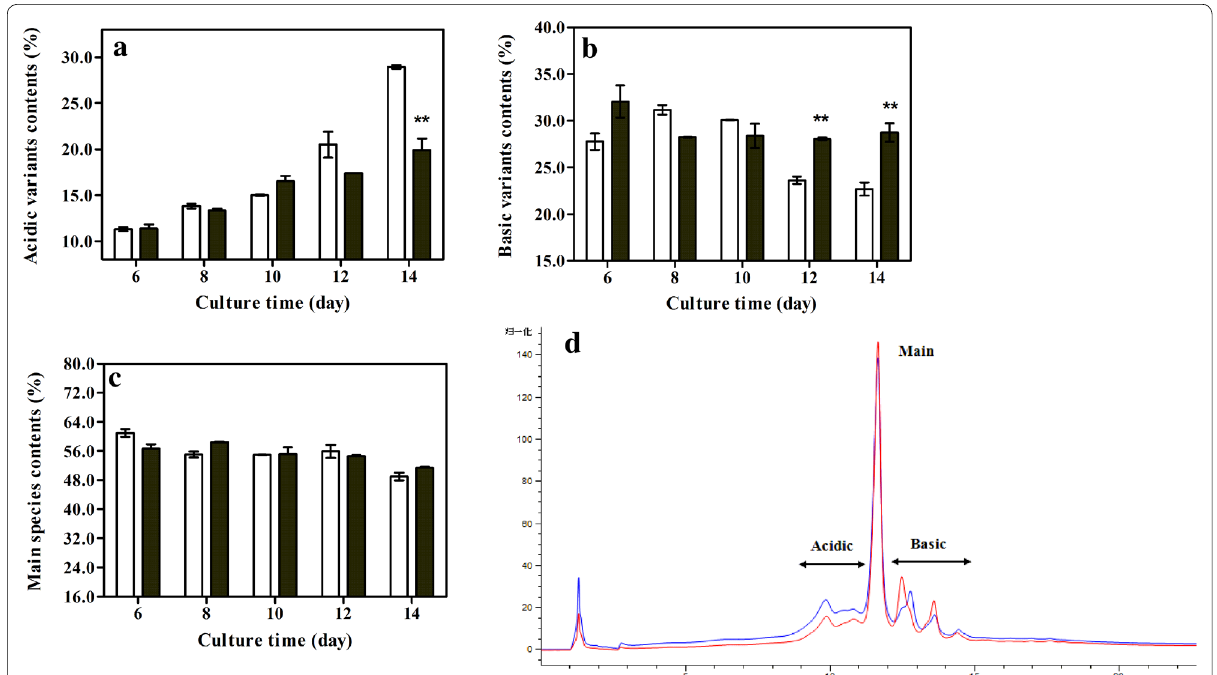
Fig. 2 Profiles of mAb charge variation distribution with different feed medium. a Acidic variant level; b basic variant level; c main variant level. (White bar) control condition; (shaded bar) uridine added condition; d CEX graph of antibodies in different fed‑batch cultures. Red line represents mabs in control culture at day 14; blue line represents mab in uridine added culture at day 14. The error bars indicate the standard deviations from three independent experiments and p ‑values were estimated by two‑tailed Student’s t test. * p < 0.05 relative to control; ** p < 0.01 relative to